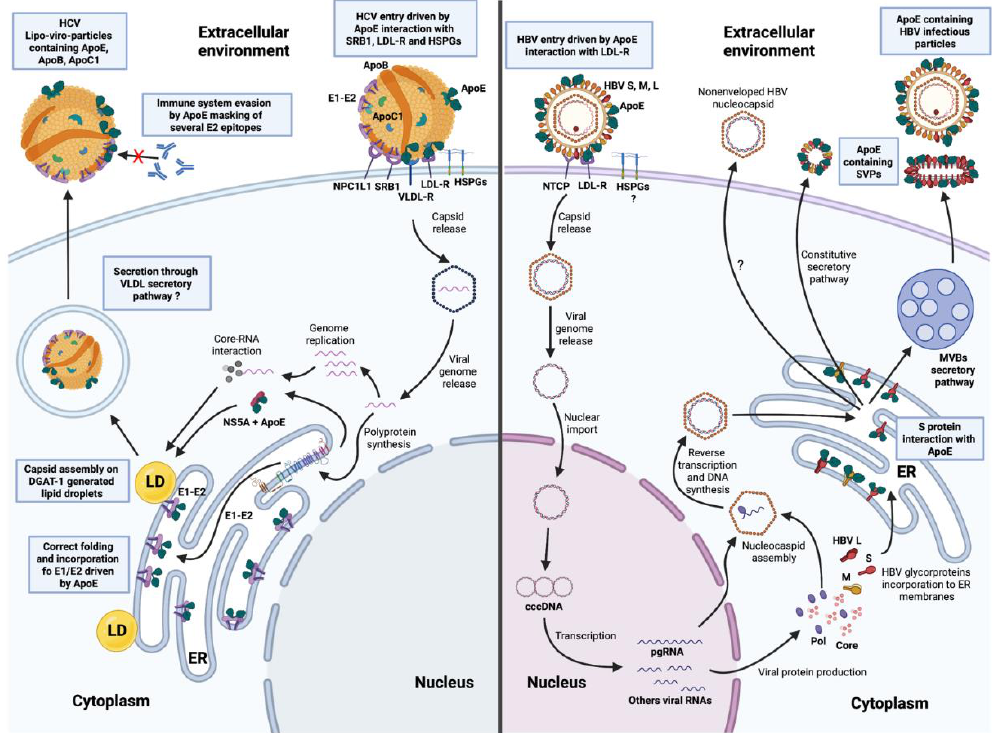
Figure 1. The crucial role of apolipoprotein E (ApoE) in the life cycles of both HCV and HBV. Left panel: HCV lipoviro particle (LVPs, containing lipoprotein components such as ApoE, ApoB, ApoC1 and triglycerides) entry is driven by E2 interaction with CD81, claudin 1 and occludin (not represented in the figure) and ApoE interactions with scavenger receptor class B type 1 (SR-B1), low-density lipoprotein receptor (LDL-R), very low-density lipoprotein receptor (VLDL-R) and heparan sulfate proteoglycans (HSPGs), expressed on the surface of the host cell. After viral entry and capsid release, the viral genome is released into the cytoplasm, where it is replicated and translated into a polyprotein targeted to the endoplasmic reticulum (ER) membrane. E1 and E2 envelope glycoproteins are associated with the ER membrane and interact with ApoE, ensuring their correct folding and future incorporation into the nascent viral particles. At the same time, the non-structural NS5A protein also interacts with ApoE and is targeted to DGAT-1-generated lipid droplets (LD). E1-E2-ApoE complexes interact with the core-RNA complex at an undefined LD-related site. The nascent particles incorporate several lipoprotein components during trafficking and may be secreted via the VLDL secretory pathway. Right panel: ApoE-containing HBV particle entry into host cells is driven by interactions between S protein and the NTCP receptor, but also between ApoE and LDL-R. The HBV capsid is then released, and the HBV genome is translocated to the nucleus to form the covalently closed cDNA (cccDNA). This cccDNA is the template for the production of the pregenomic RNA (pgRNA) and other viral RNAs, which are translated to produce viral proteins. The HBV S,